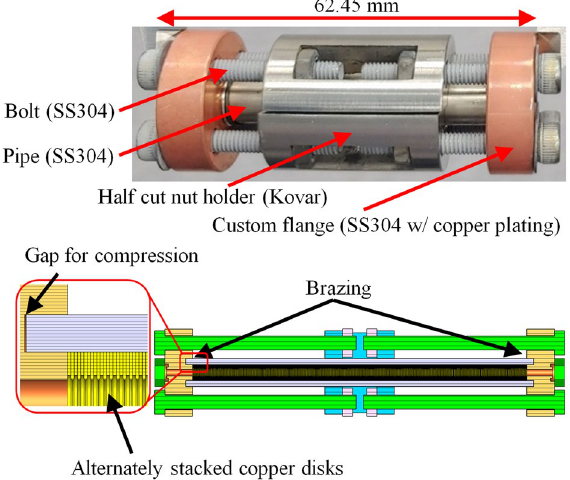
Figure 3. Picture and schematic of a structure assembly for diffusion bonding.